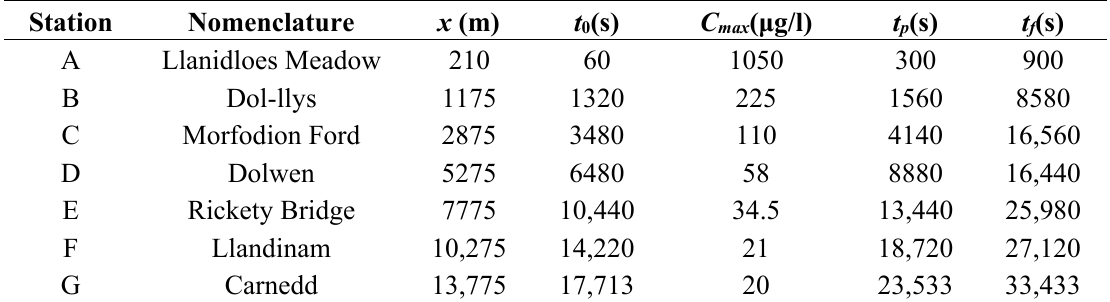
Table 1. Characteristic parameters of pollutant concentration temporal